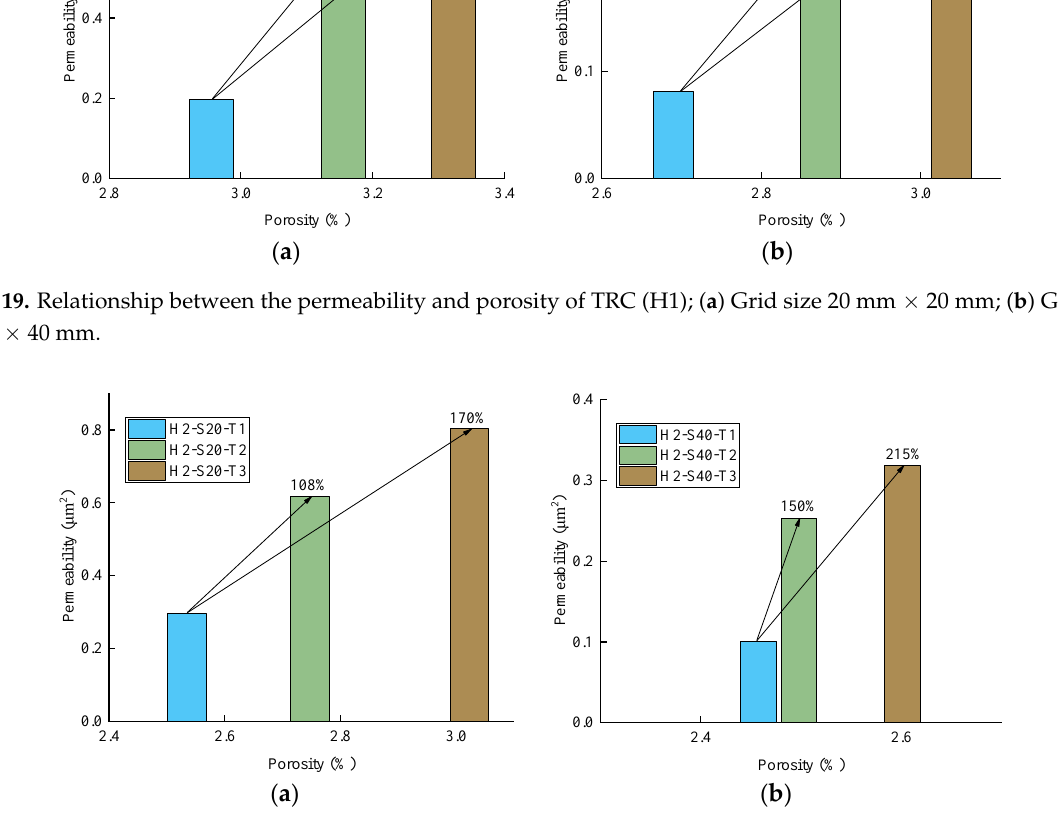
Figure 20. Relationship between the permeability and porosity of TRC (H2); ( a ) Grid size 20 mm × 20 mm; ( b ) Grid size 40 mm × 40 mm.